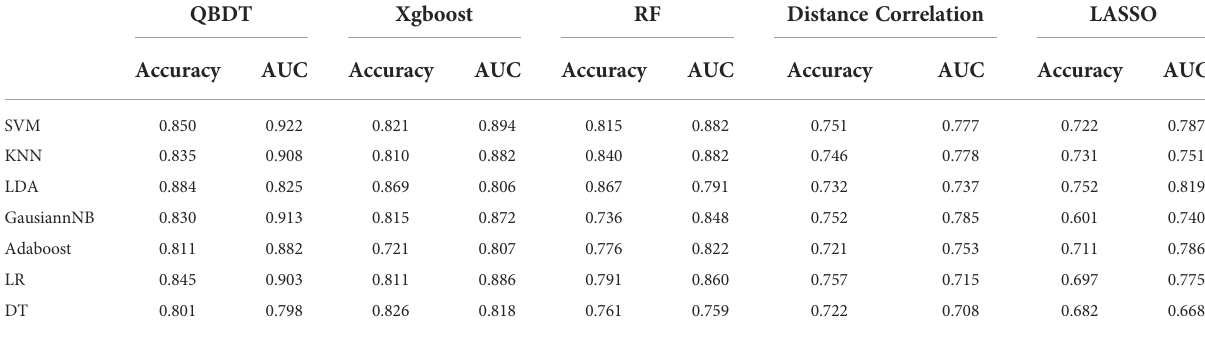
TABLE 3 Results of discriminative CMs in group 1 in the testing group.